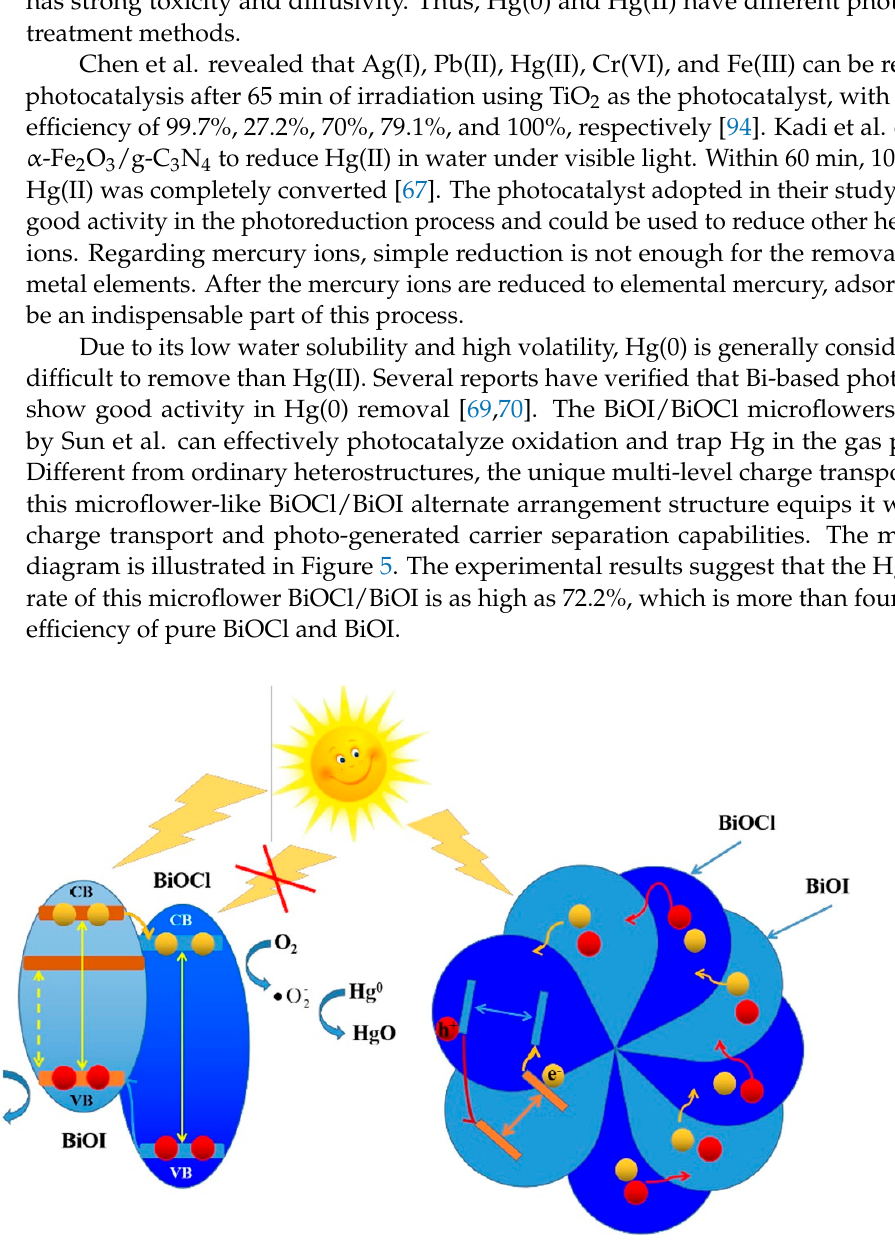
Figure 5. The mechanism of photocatalytic removal of gas-phase Hg(0) under visible light (Adapted from [68]).